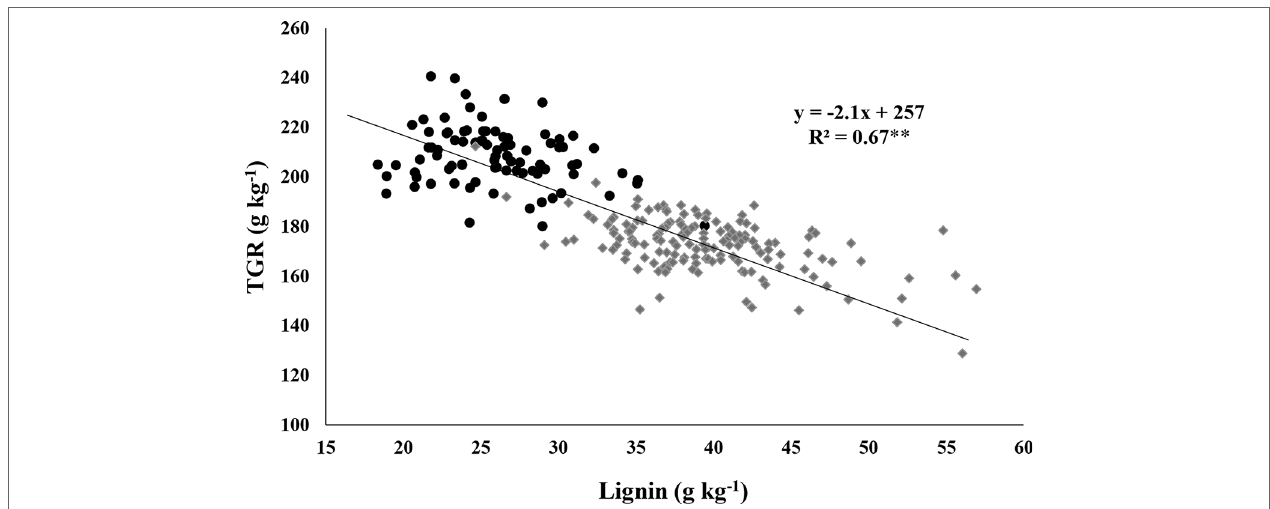
FIGURE 1 | Distribution of theoretical glucose recovery (TGR) from cellulose and lignin measured from stover samples of individual RIL averaged over two years. Data points appearing as black circles represent RIL with brown midribs (“brown” and “brown-sweet” groups), those as grey diamonds are RIL with non-brown midribs (“normal” + “sweet” groups). **Significance at P < 0.01.